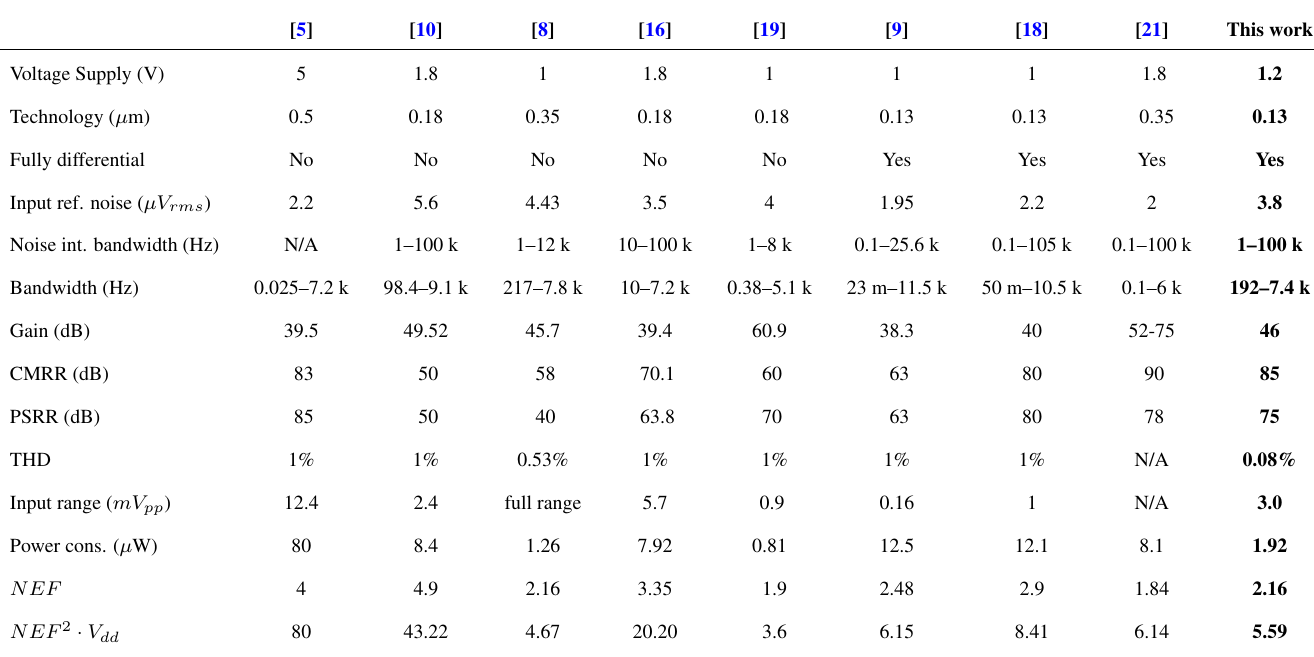
Figure 17. Neural spike activity recorded by the LNA by using a penetrating microelectrode. The zoom shows a single spike. Table 4. State-of-the-Art Comparison of the LNA Measured